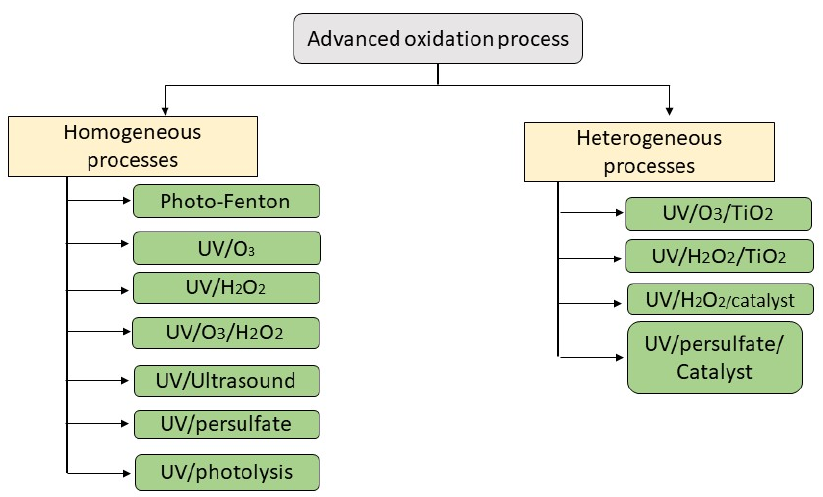
Figure 2. Classification of Advanced Oxidation Processes